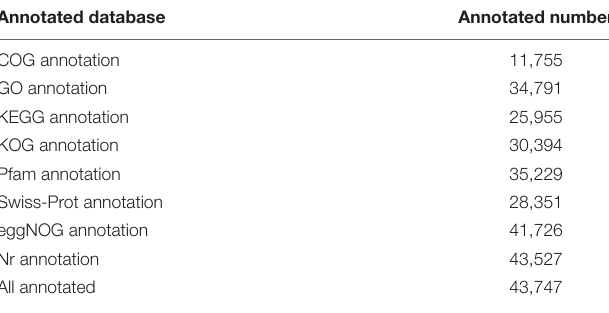
TABLE 2 | Summary of annotations on non-redundant transcripts from bone tissues against public